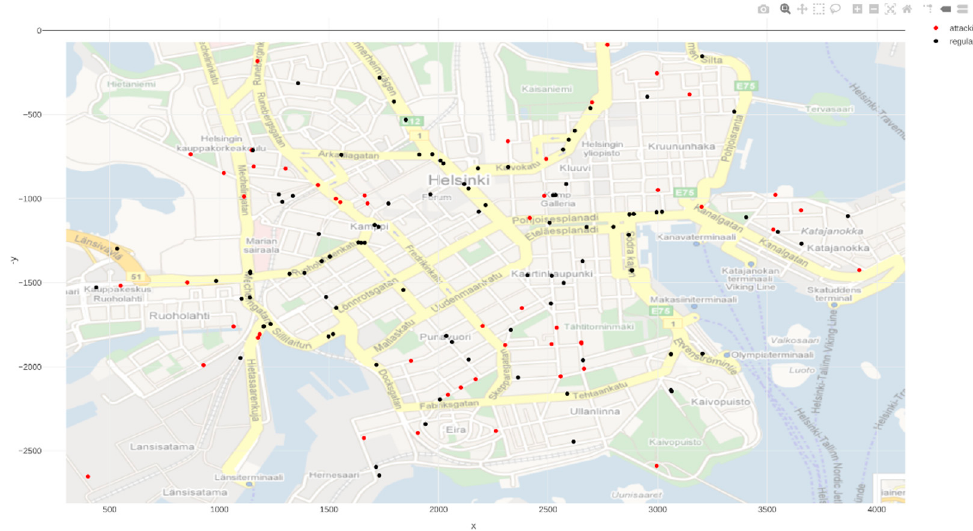
Figure 5. Geospatial Plot of vehicles at a single point in time.